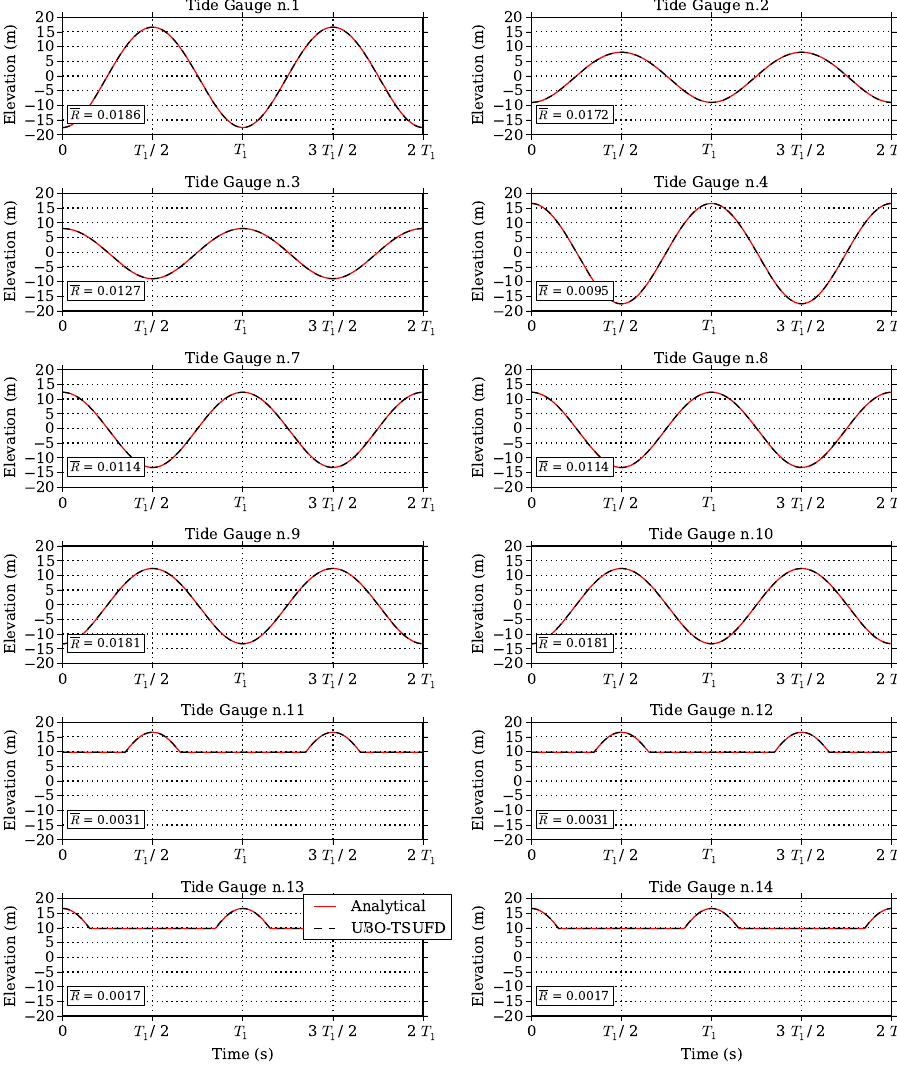
Fig. 10. Benchmark n. 2: calculated tide gauge records (black dashed line) compared to the analytical solution (red solid line) for the planar oscillation along the x-axis. All records of nodes with negative x coordinates are in phase, while the ones corresponding to positive x coordinates are phase-shifted by half period (see Fig. 8). The oscillation is dominated by the period T 1 . From records of nodes that are always wet, it is easy to also see the influence of the frequency zero that introduces a non-zero average elevation, and makes the modules of maximum and minimum values quite different from each other. Gauges 11, 12, 13 and 14 are on land at the same altitude, and are intermittently dry and